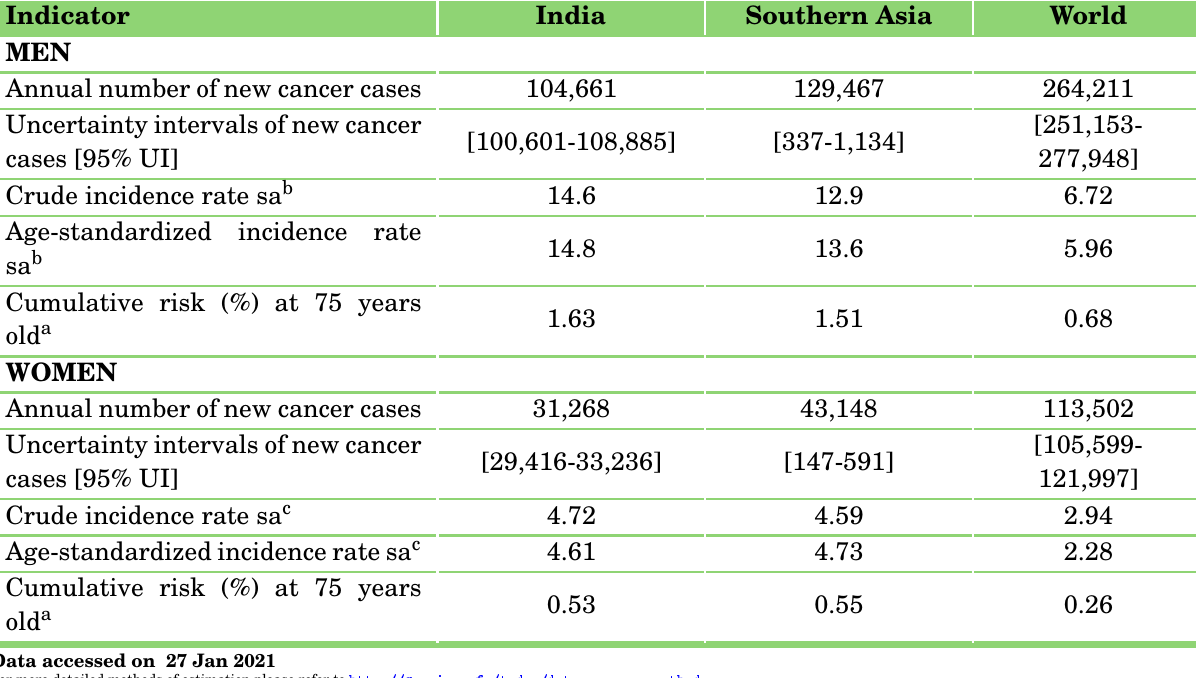
Table 17: Oral cavity cancer incidence in India (estimates for 2020)